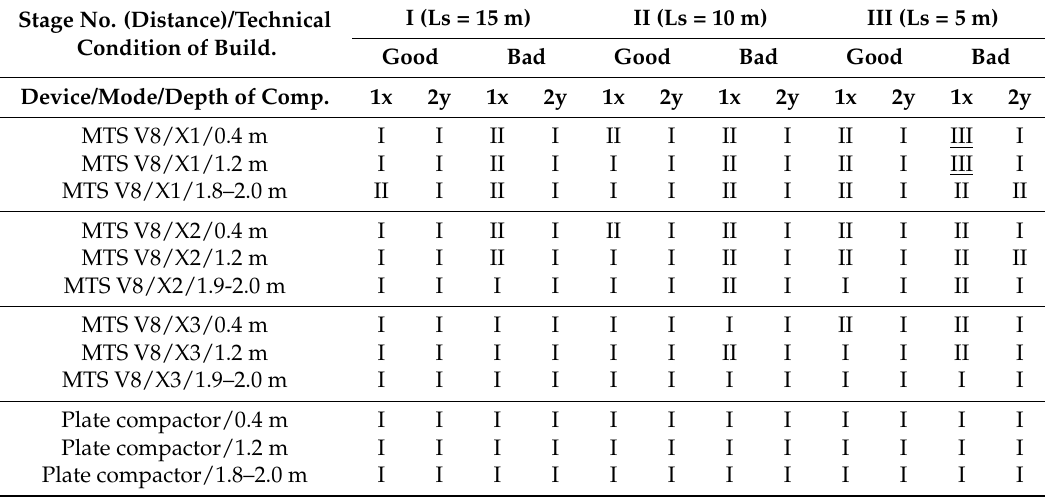
Table 9. Impact of vibrations on a residential building according to the dynamic impact scale